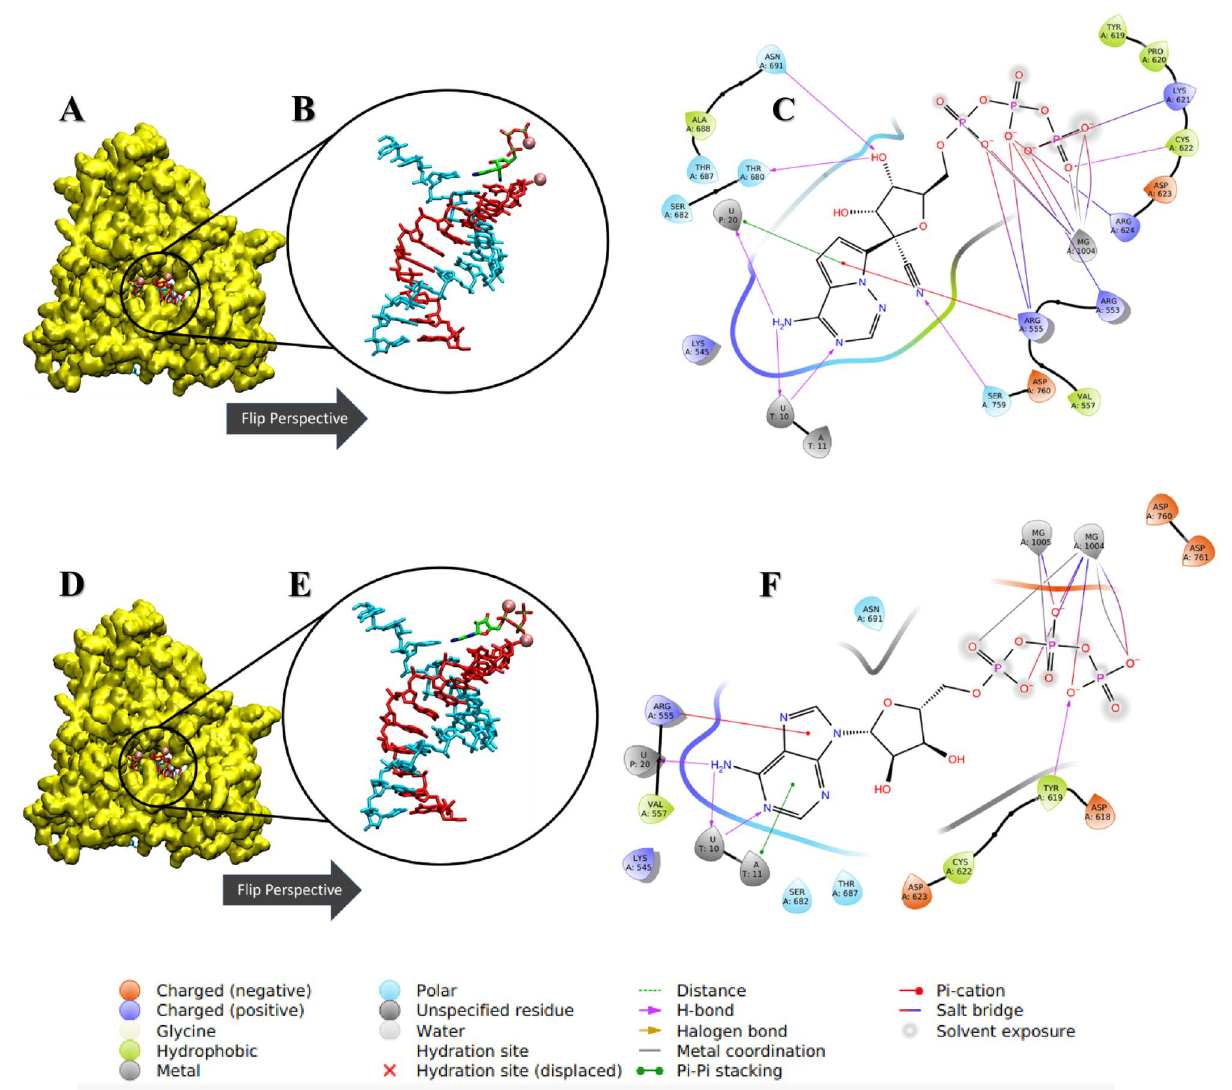
Figure 3. Ligand–receptor interaction diagrams and representations of the most abundant conformational pose from MD simulation. ( A,D ) The 3D surface representation of SARS-CoV-2 RdRp colored in yellow. ( B,E ) Zoomed and rotated perspective of the template-primer RNA in complex with ATP and RTP, respectively. ( C,F ) The detailed receptor-RNA-ligand contacts of the most abundant conformational pose of ATP and RTP, respectively. Template and primer strands represented in blue and red licorice, respectively. Ligands are colored in green and magnesium ions are represented as pink